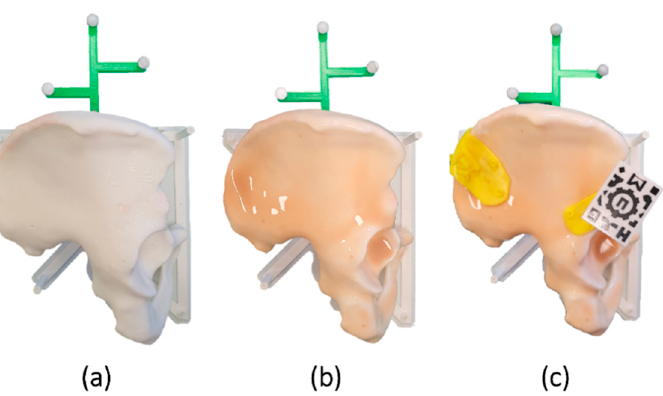
Figure 1. ( a ) Conventional bone phantom and ( b ) realistic phantom including a silicone layer. ( c ) patient-specific instruments (PSIs) and augmented reality (AR) marker placed on the phantom. Six scenarios were designed for tumor resections in the ilium (type I according to Enneking and Dunham’s classification [31]). Each scenario was composed of two PSIs indicating the osteotomies, one in the supra-acetabular region (S) and one in the iliac crest (C). The designed PSIs presented different sizes, shapes, and locations inside the target region. All PSIs were created in Meshmixer following the steps described by Garc í a-Sevilla et al. [13] and 3D printed in polylactic acid (PLA) (Figure